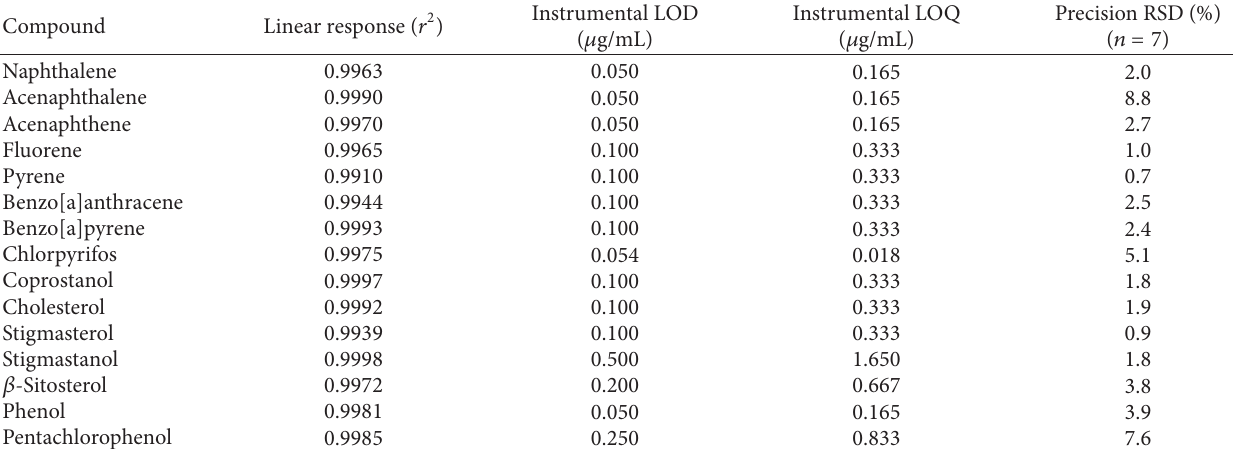
T 3: Analytical performance on the proposed method, PLE packed with silica in the extraction cell.